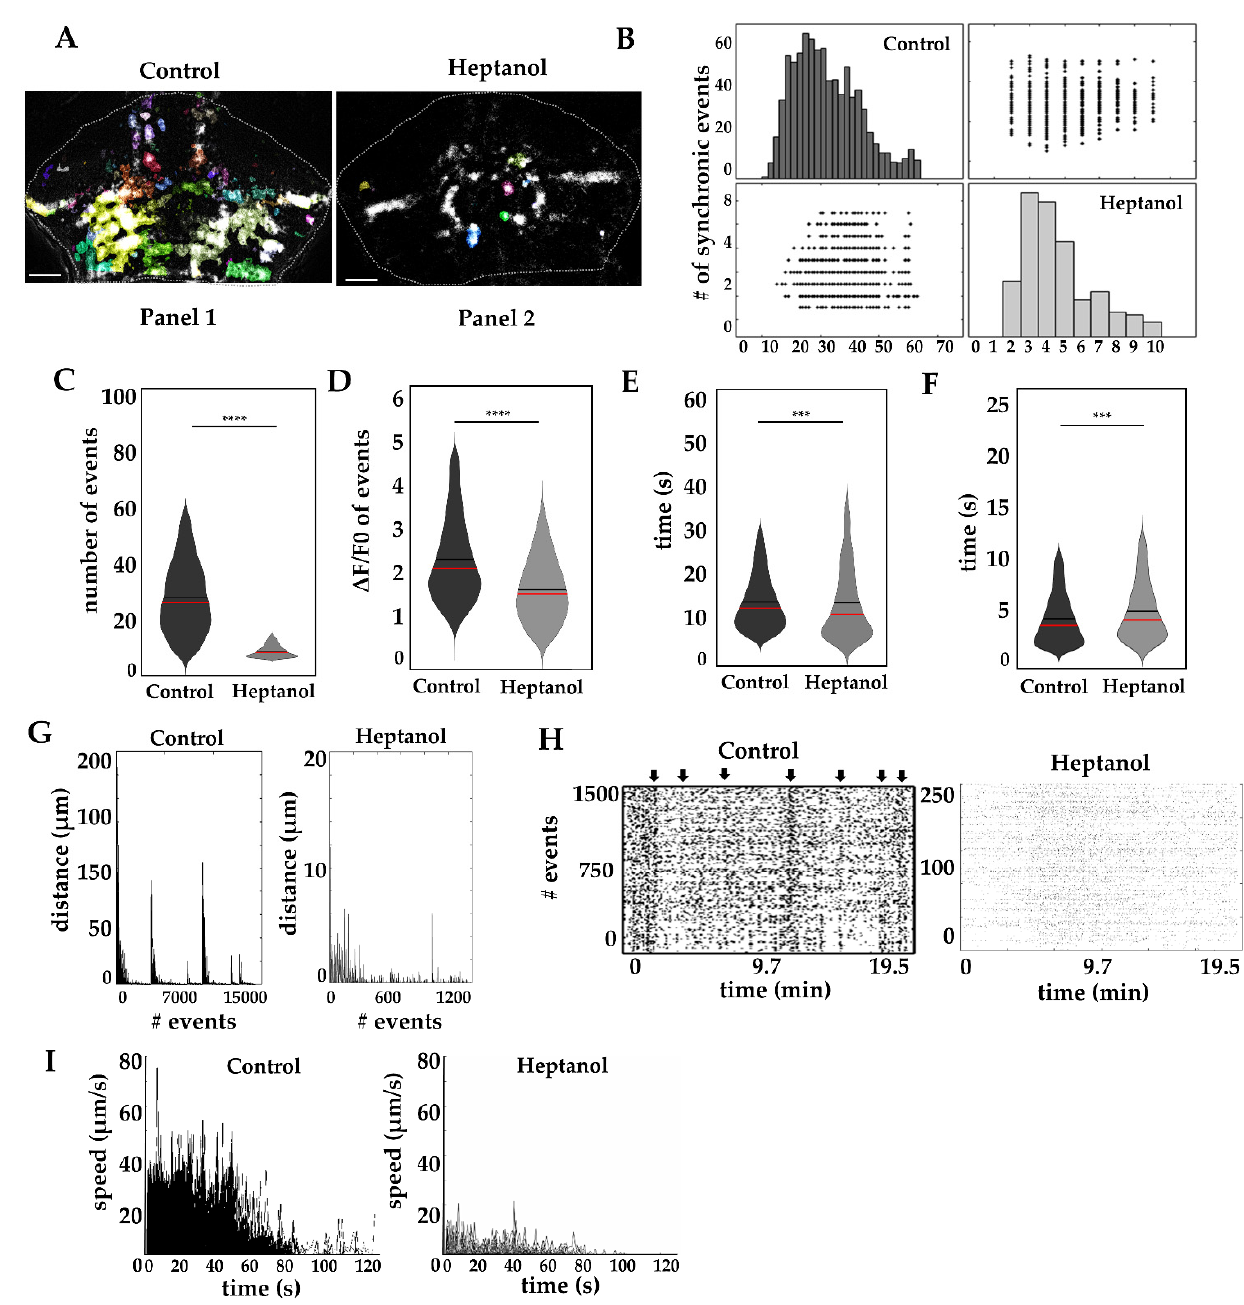
Figure 5. Calcium waves disruption in radial glia. ( A ) Calcium events in fish cerebellum after heptanol treatment (events with changes in fluorescence are shown with a multicolor mask, and the white dashed line delineates the cerebellum). Panel 1, long-distance spreading in control cerebellum, Panel 2 non-spreading events in heptanol treated fish. ( B ) Synchronic calcium events are reduced by heptanol treatment (black and gray bars, control and heptanol respectively. Scatter plot of x columns against y axes) ( C ) Number of calcium events in 19.5 min. ( D ) Amplitude ( Δ F/F0). ( E ) Duration (in seconds). ( F ) Rise time (in seconds). ( G ) Propagation distance (in µm) of calcium events. ( H ) Raster plots of calcium waves (each region of interest is aligned in time and each event is represented by a black dot, black arrows indicate the time of occurrence of a calcium wave). ( I ) Maximal speed of calcium waves (µm/s). The box plots show data mean values (black line), media (red line) and data distribution. Non-parametric statistics, Mann–Whitney U test, α 0.05, p -value < 0.0001 ***, 0.00001 ****. Al recordings were obtained from 5 dpf larvae. 6 larvae were recorded for each condition. Calcium events recorded in control fish n = 14,348 and in heptanol n = 1467. Scale bar in A 50 µm. Basal cerebellar calcium activity of a fish treated with 500 µM heptanol for 30 min is shown in Supplementary Video S2, and Figure 5 shows sample images selected from the